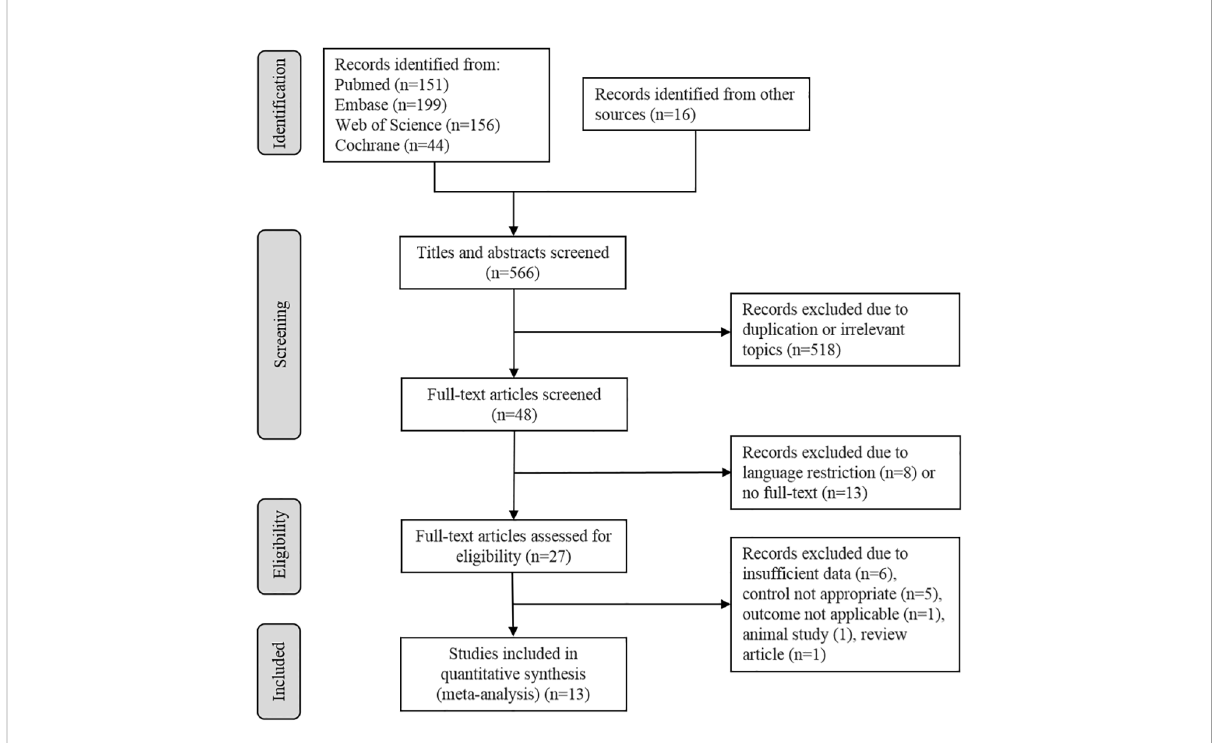
FIGURE 1 Flow diagram describes the selection process of the included